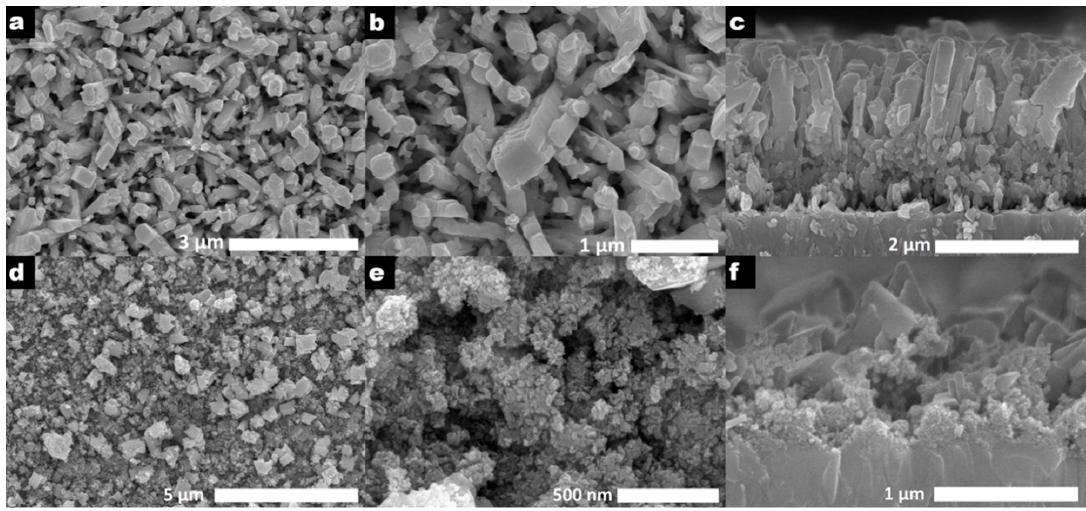
Figure 1. Low ( a and d ) and high ( b and e ) resolution surface and ( c and f ) cross-section SEM images Figure 1. Low ( a , d ) and high ( b , e ) resolution surface and ( c , f ) cross-section SEM images of undoped of undoped and Sn-doped WO 3 , respectively. and Sn-doped WO 3 ,